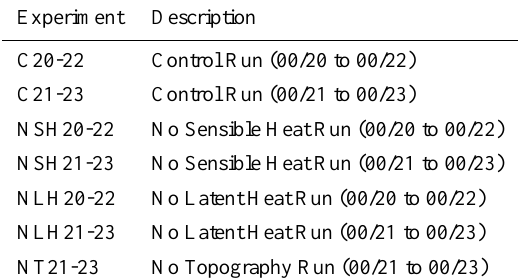
Table 1. Description of numerical experiments. Dates are given in HH/DD of December1979 and correspond to initial and ending times of the experiments